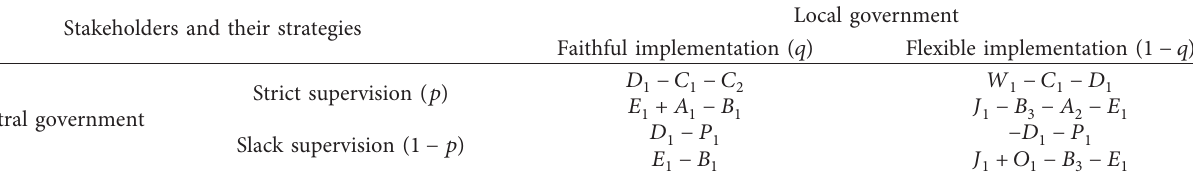
Table 1: Payoff matrix of the central government and the local